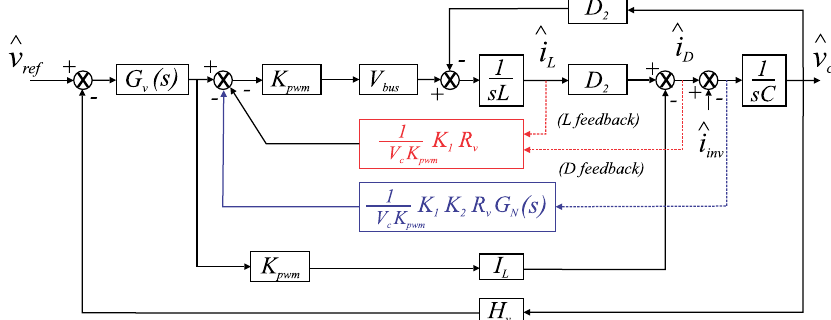
Figure 27. Notch-filter-inserted load current feedforward scheme (NF-LCFFS).